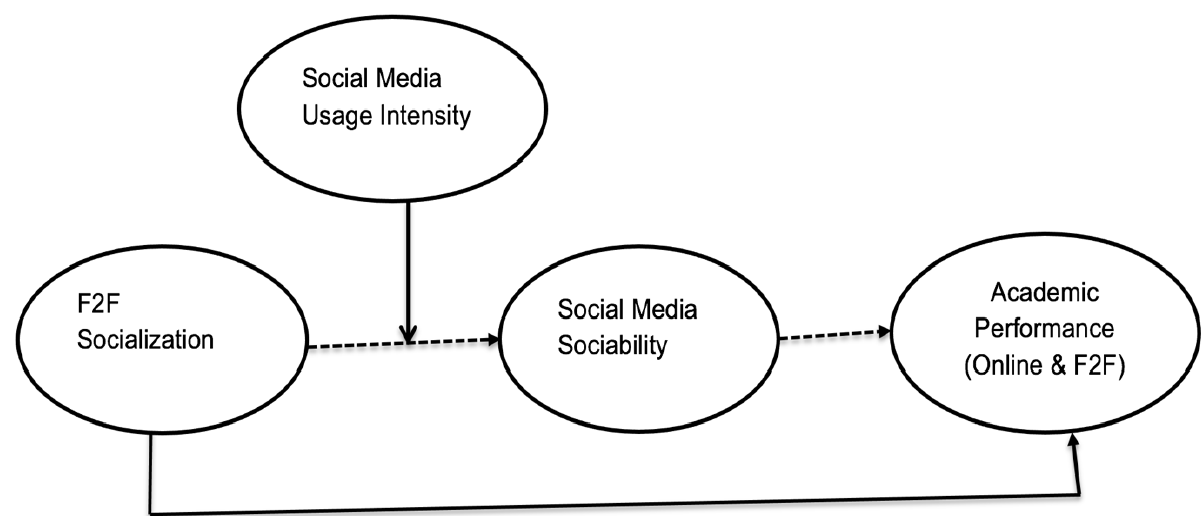
Figure 1. The conceptual framework.